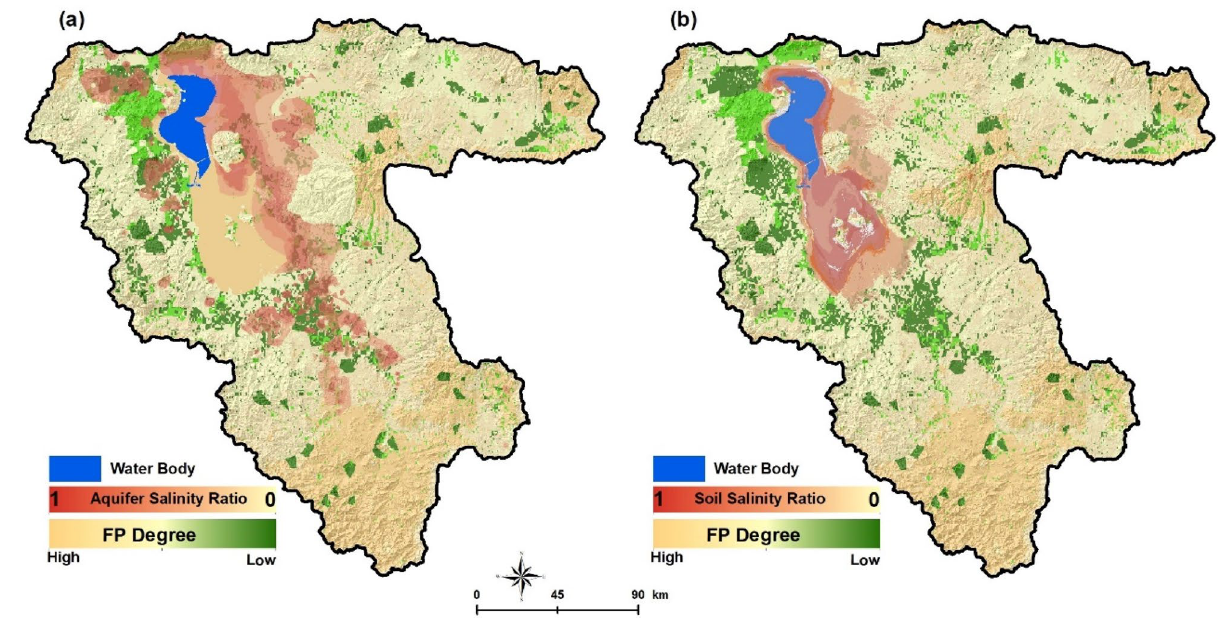
Figure 7. Results of the scenario-based food production for 2050 and its spatial correlation with aquifer salinization ( a ) and soil salinity ( b ). The FP degree was computed based on the CA-Markov method. The green color shows the farmlands and red color indicates how the expansion of the soil and aquifer salinization has impacted the productivity of the farmlands. Figure created in Arc GIS 10.7 ESRI, https:// www. esri. com/.